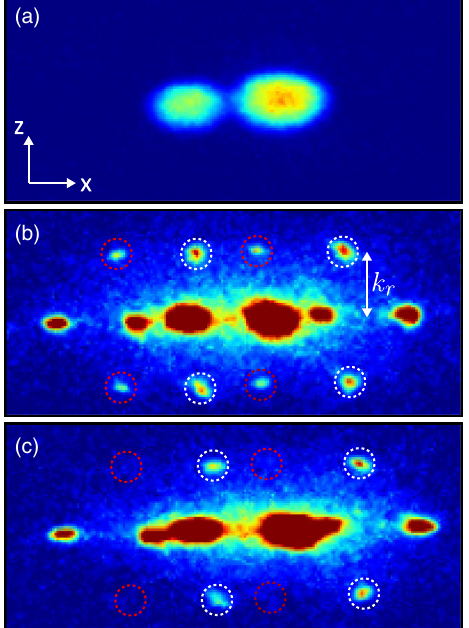
FIG. 7. Tunability of the effective number of coupled modes, proportional to the square of M (cid:2) , and interaction range ξ versus (cid:2) on Δ δ L and Δ 0 ; 0 . (a) The dependence of M 0 ; 0 for various cavity lengths δ L . The solid lines are a fit to the theoretical expectation, M (cid:2) ∼ Δ 0 = ϵ . (b) The dependence of the interaction range ffiffiffiffiffiffiffiffiffi p ; 0 ¼ 1 = 2 M (cid:2) ξ =w inferred from the data in panel (a). on Δ 0 0 ; 0 We measure an interaction range of ξ =w 0 ¼ 0 . 09 ð 1 Þ at the largest value of Δ 0 studied in the confocal configuration. This is over ; 0 an order of magnitude smaller than the TEM 0 waist w 0 . Solid ; 0 lines are the same fits to the theoretical interaction profile as . c above. The dashed lines are extensions of the fitted curve outside the regions of validity; i.e., where M (cid:2) < 1 . Inset: Agreement between interaction ranges extracted from the single-cloud (unfilled squares) and two-cloud (filled circles) data sets for δ L ¼ 0 μ m. The solid line is a fit to the single-cloud data. All error bars represent standard error. is c